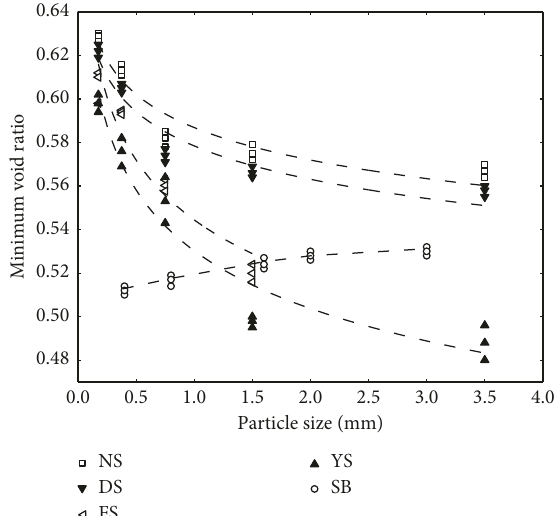
Figure 3: The minimum void ratios corresponding to single particle groups of different sand